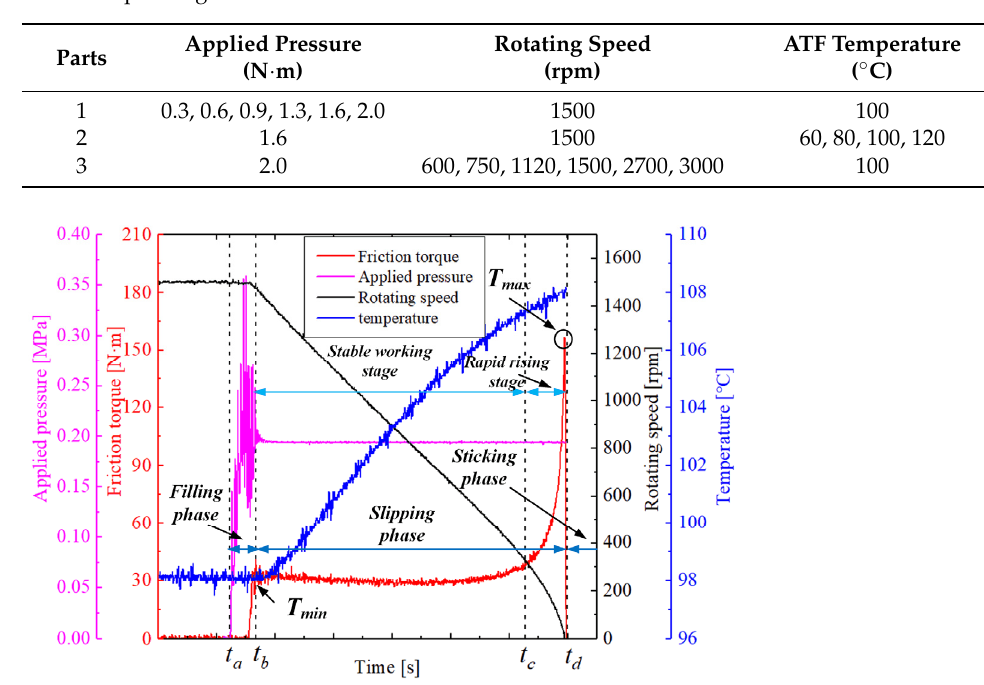
Table 1. Operating conditions.